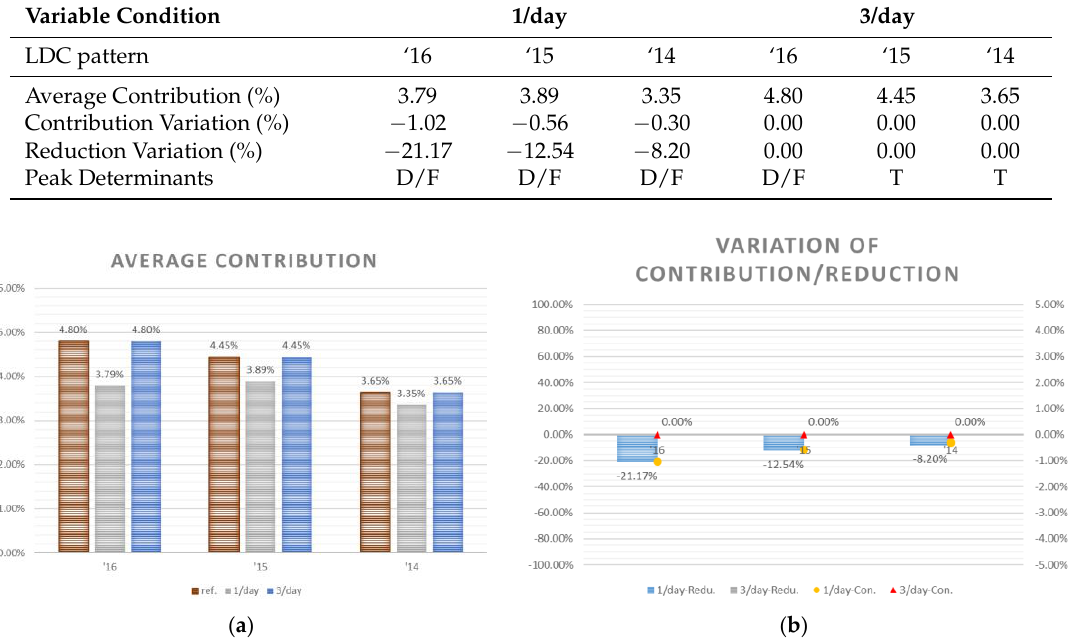
Table 10. Summary of sensitivity simulation results with the allowed number of dispatches per day.